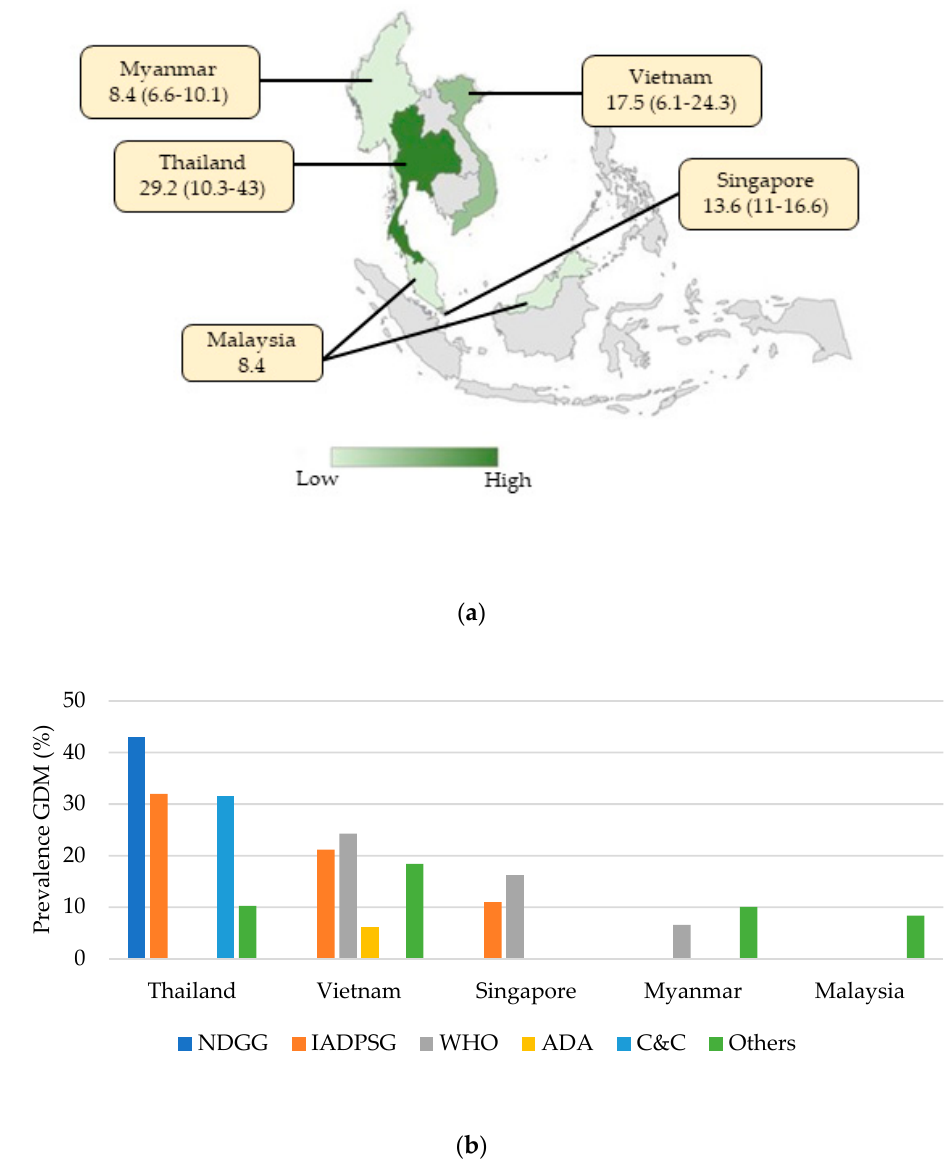
Figure 4. ( a ) Southeast Asian prevalence of GDM in 2010–2020. Note: Median (interquartile range) prevalence (%) of gestational diabetes mellitus (GDM) in 2010–2020. A literature search was conducted for eligible studies on the prevalence of GDM from 1 January 2010 to 25 May 2020 to capture the contemporary burden of GDM. Among the eligible studies that met the search criteria, data from countries reported in the studies were included to derive country-specific estimates for GDM prevalence. The country-specific prevalence of GDM was estimated by calculating the median prevalence of country-specific estimates within each country. ( b ) Country-specific prevalence of GDM according to different diagnostic criteria. Note: Graph of the prevalence of gestational diabetes mellitus (GDM) in selected countries according to the Carpenter–Coustan criteria (C&C), International Association of Diabetes and Pregnancy Study Groups (IADPSG) criteria, National Diabetes Data Group (NDDG) criteria, WHO 1999/2013 criteria, and International Classification of Diseases codes and local guidelines or criteria (other). A literature search was conducted for eligible studies on the prevalence of GDM from 1 January 2010 to 25 May 2020 to capture the recent burden of GDM. Among the eligible studies that met the search criteria, data from countries reported in the studies were included to derive country-specific GDM prevalence estimates based on different diagnostic criteria. The median of all available source data was used if more than one estimate of GDM prevalence was available for a